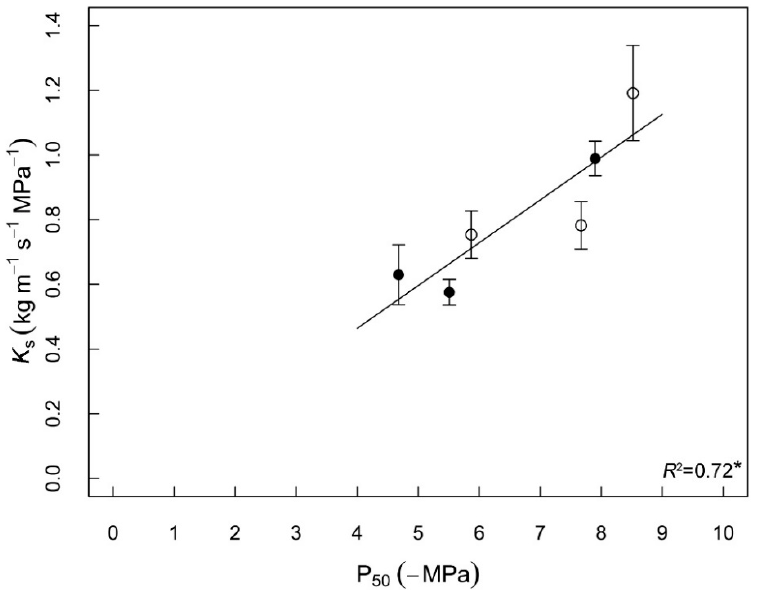
Figure 3. The relationship between water potential at 50% loss of conductivity (P 50 ) and sapwood- specific hydraulic conductivity ( K S ) across the two mangrove species in the three sites. Open circles represent Avicennia marina and filled circles represent Aegiceras corniculatum . Error bars indicate standard error of mean. Adjusted R 2 of significant Pearson’s correlation is shown. Asterisk indicates significance). Asterisk indicates significance level (* p < 0.05).